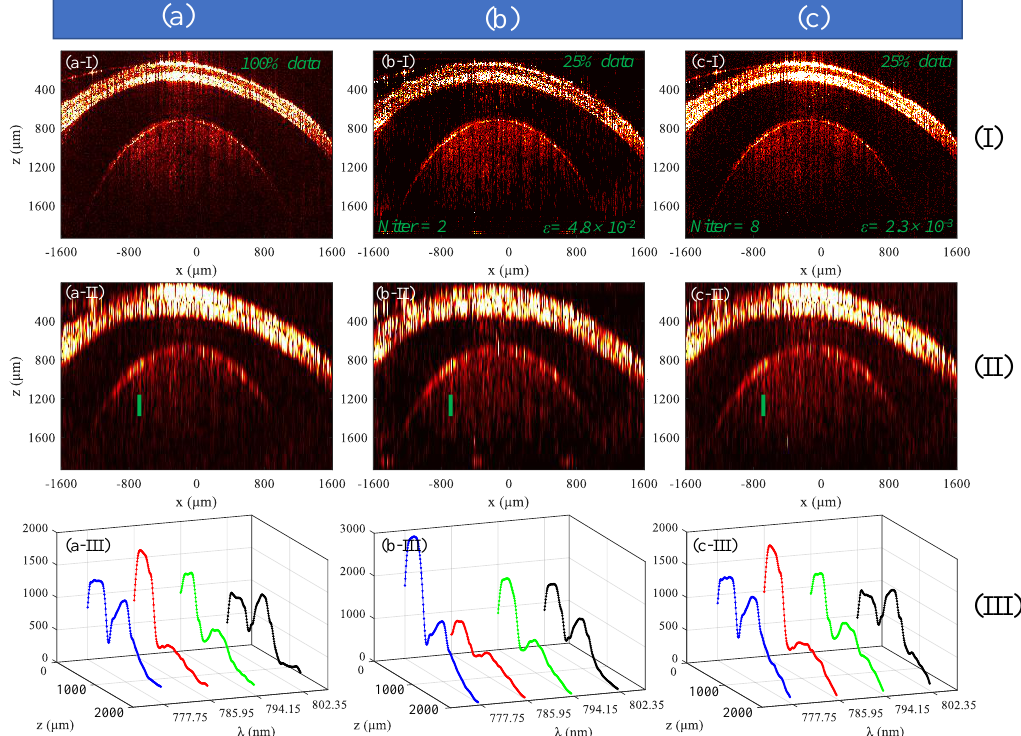
Figure 6. Experiment results of functional sensing. The results in ( a ) were obtained using 100% data. ( b ) and ( c ) are the results after 2 iterations and 8 iterations using 50% × 50% data. ( I ) The structural image obtained by implementing IFFT on spectral data; ( II ) the structural image obtained by implementing STFT on spectral data; ( III ) depth-resolved spectrum H ( k , 0:2000 μm). For clarity, only the curves of four wavelengths were plotted in ( III ).